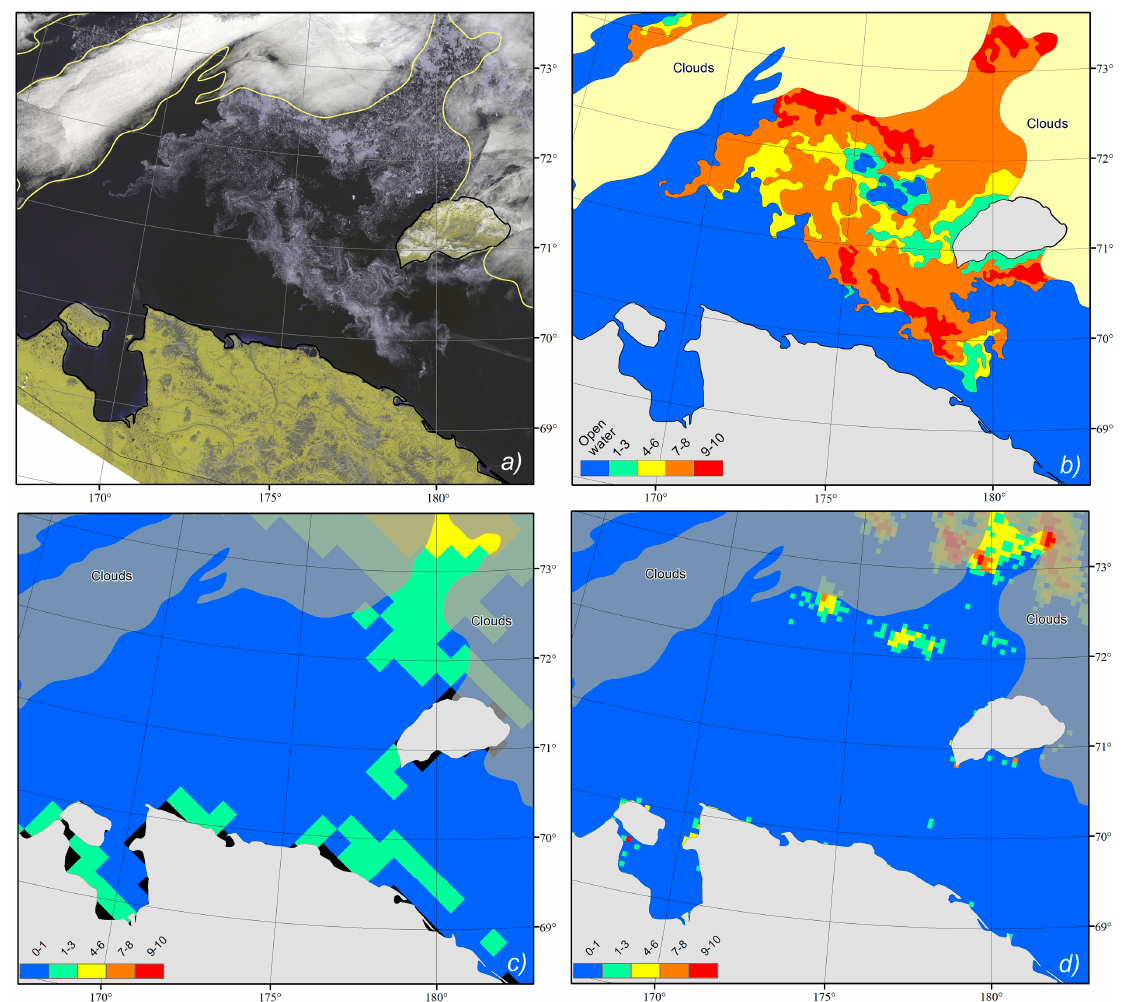
Figure 6. Ice cover in the east of the East Siberian Sea on 26 July 2017: ( a ) Terra MODIS (or Moderate Resolution Imaging Spectroradiometer), 00:30 UTC (Coordinated Universal Time), RGB (Red, Green, Blue) composite of bands 2-2-1; ( b ) Arctic and Antarctic Research Institute (AARI) overview SIC chart based on Terra MODIS image ( a ), ( c ) SIC derived from NASA Team (NT) algorithm, resolution 25 km (dataset Sea Ice Concentrations from Nimbus-7 Special Sensor Microwave Radiometer (SMMR) and Defence Meteorological Satellite Program (DMSP) Special Sensor Microwave Imager (SSM/I) - Special Sensor Microwave Imager Sounder (SSMIS) Passive Microwave Data, Version 1 (NSIDC-0051)); ( d ) SIC derived from Arctic Radiation and Turbulence Interaction Study (ARTIST) Sea Ice (ASI) algorithm, resolution 6.25 km (version 5.4.). Both the radiometer-derived SIC charts are shown at the same scale as the AARI one. In ( b ), ( c ) and ( d ), the SIC is in tenths: 0-1 corresponds to 0%–9%, 1–3 to 10%–30%, 4–6 to 31%–60%, 7–8 to 61%–80%, and 9–10 to 81%–100%.